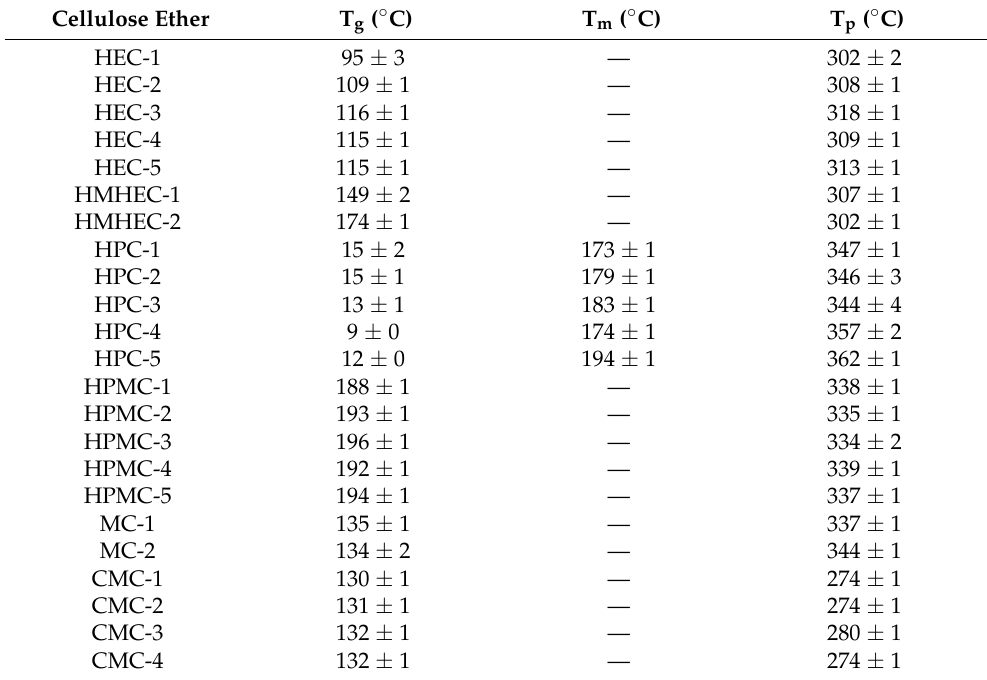
Table 7. DSC (T g , T m ) and TGA (T p ) data for the cellulose ethers. Cellulose Ether T g ( ◦ C) T m ( ◦ C) T p ( ◦ C) HEC-1 95 ± 3